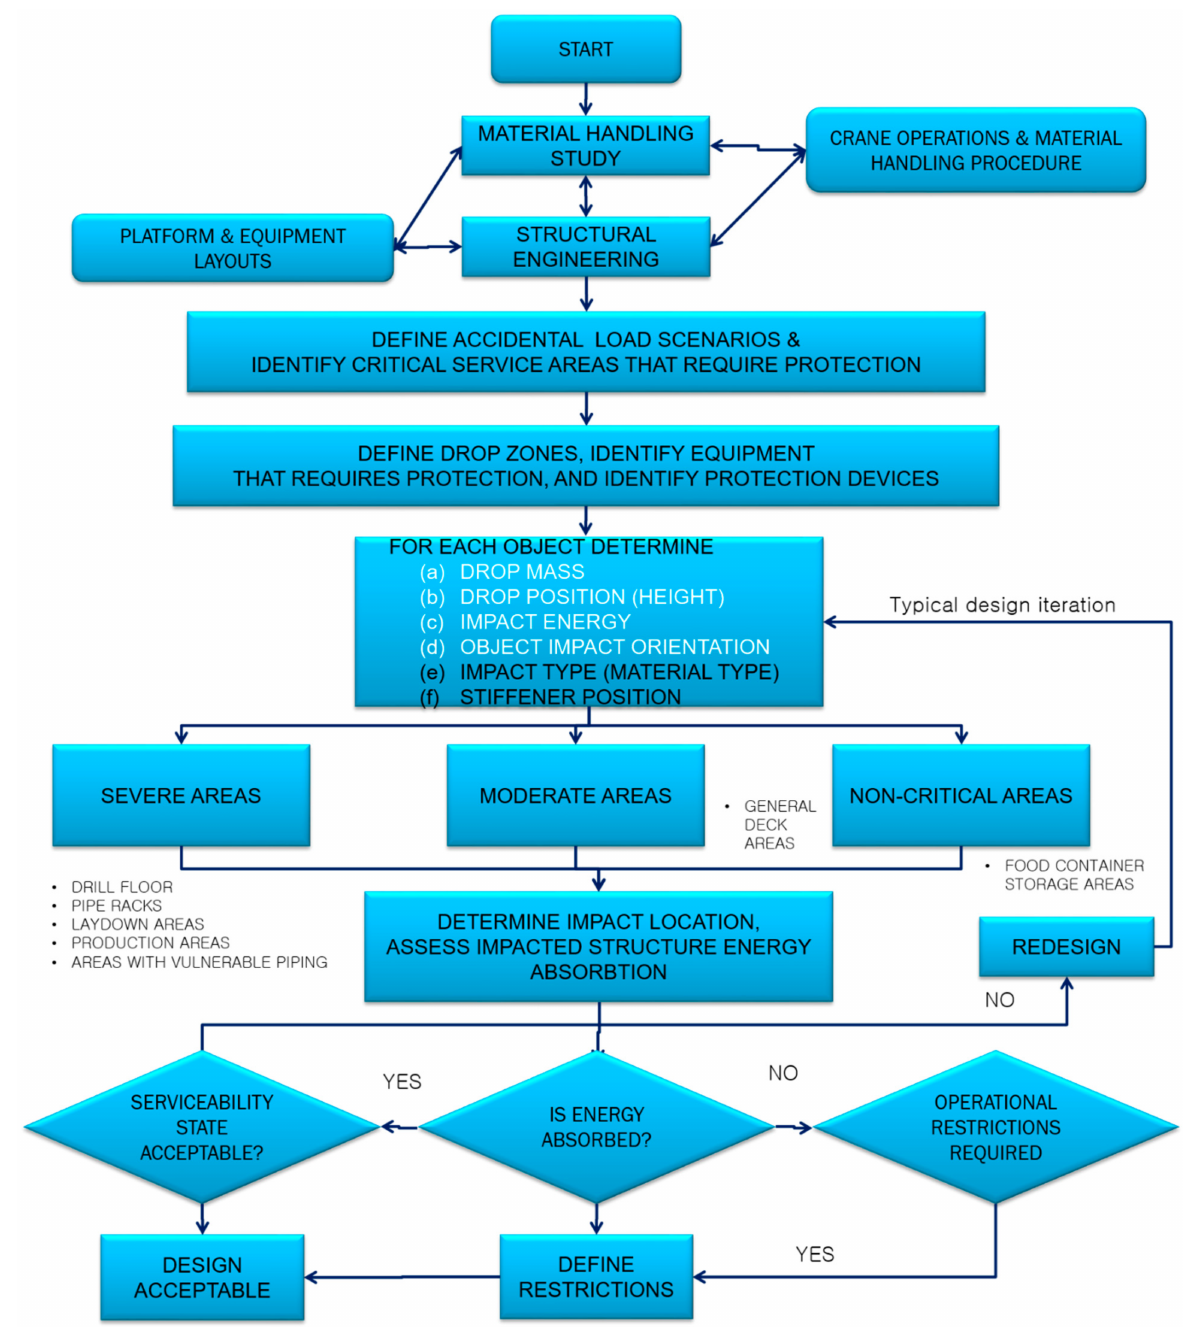
Figure 6. Detailed procedure of dropped object